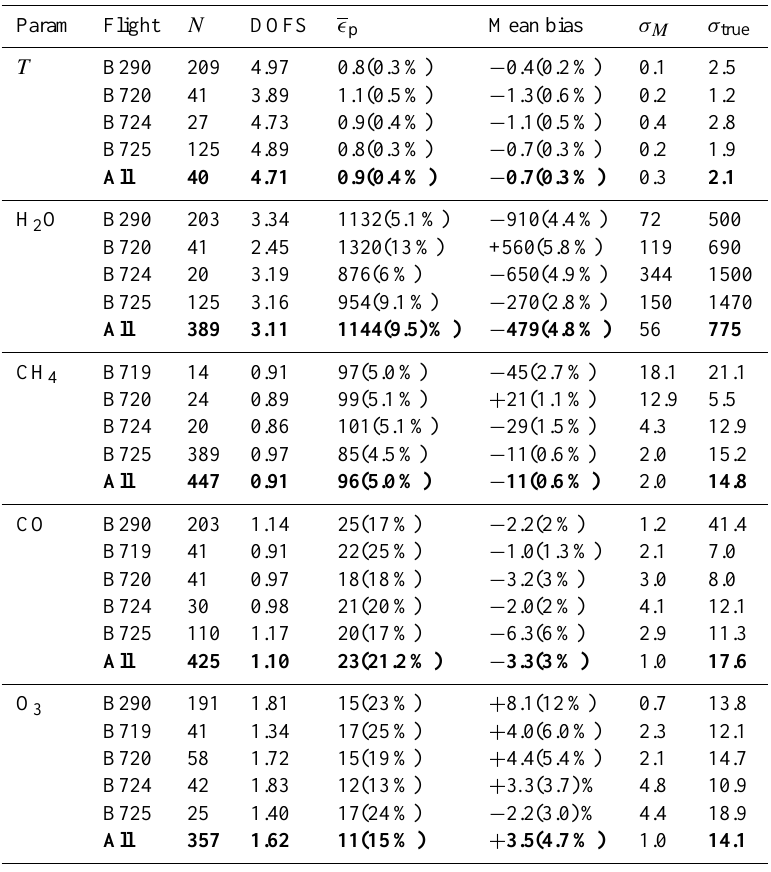
Table 3. Summary of retrieval metrics and validation results across all flights. Numbered from left to right columns show (1) target parameter, (2) FAAM flight number, (3) number of ARIES retrievals, (4) mean degrees of freedom for signal, (5) flight-mean column-averaged a posteriori retrieval uncertainty, (6) mean bias of retrieved partial columns relative to in situ data, (7) the standard error of the mean bias, and (8) the standard deviation of corresponding in situ data. For each parameter, a global sample value is shown in bold. For columns four through eight, units are K for T , ppm for H 2 O, and ppb for other gases (percentages in parentheses are relative to the mean-retrieved partial